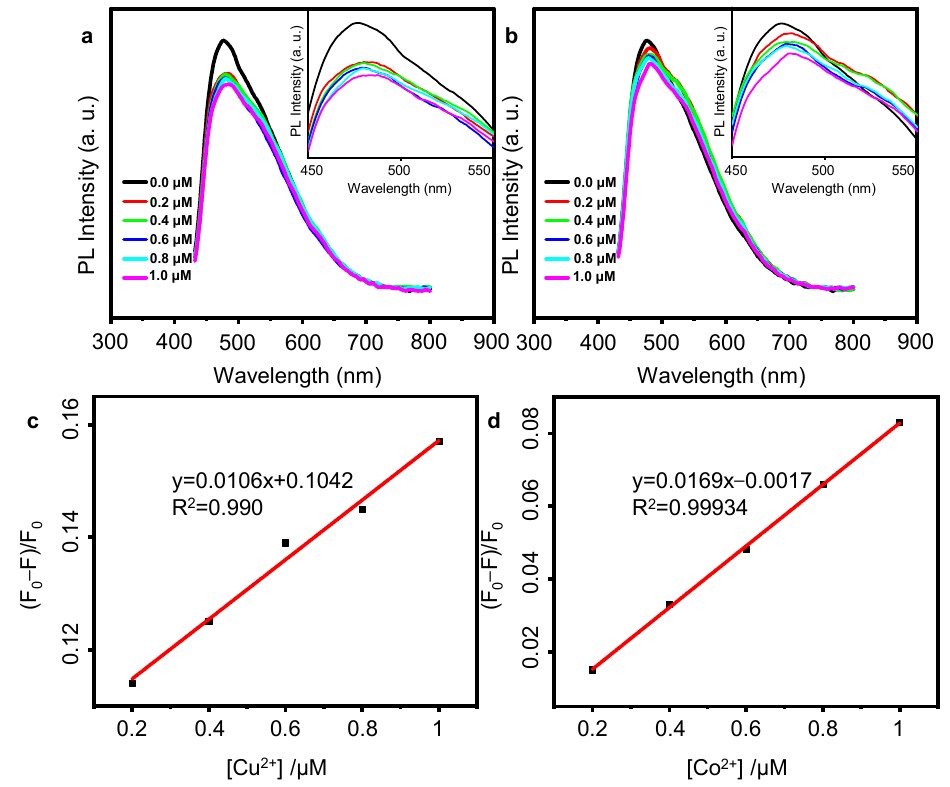
Figure 6. Fluorescence spectra of N–GQDs at different molar concentrations of Cu 2+ ( a ) and Co 2+ ( b ). Fitting curves of the fluorescence intensity difference ratio (F 0 − F)/F 0 of N-GQDs for different molar concentrations of Cu 2+ ( c ) and Co 2+ ( d ) (where F 0 is the fluorescence intensity of N–GQDs without adding Cu 2+ /Co 2+ , and F is the fluorescence intensity of N–GQDs on adding Cu 2+ /Co 2+ ).